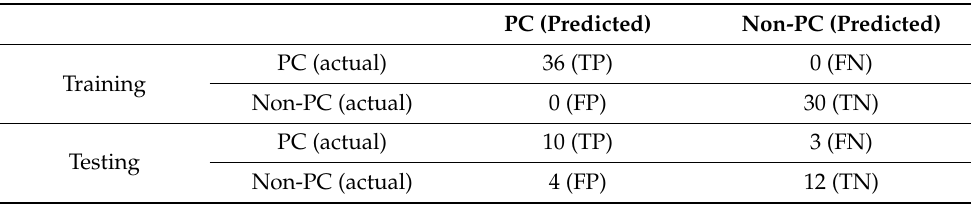
Table 5. Confusion matrix for the RF.